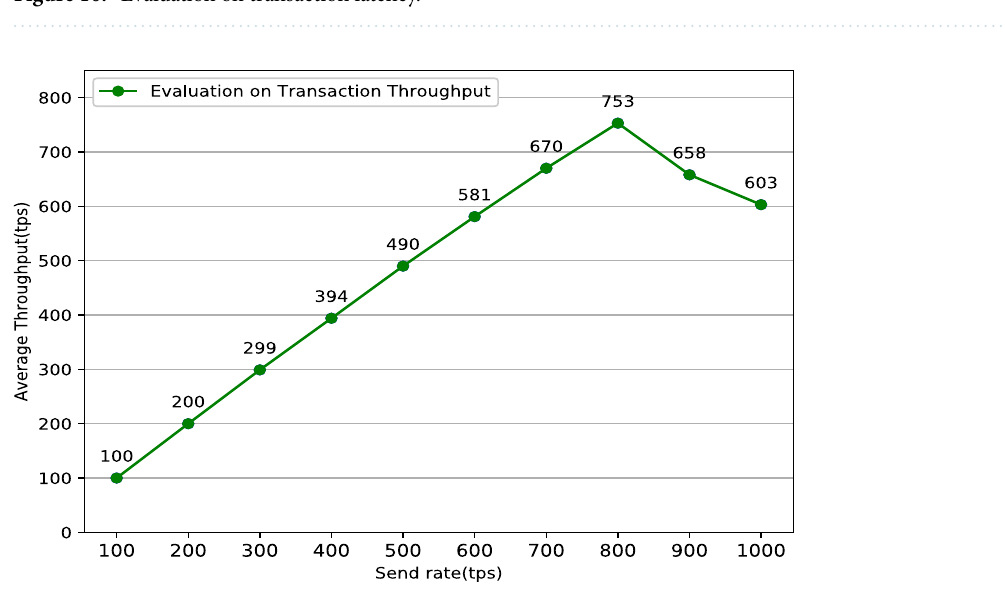
Figure 11. Evaluation on transaction